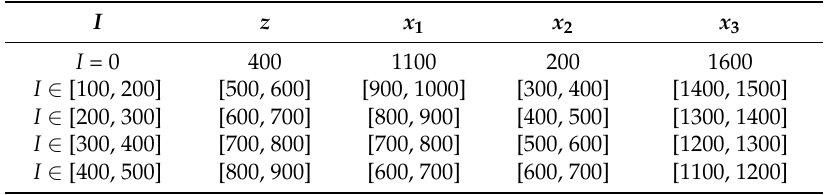
Table 1. Traffic flows with respect to different ranges of indeterminacy